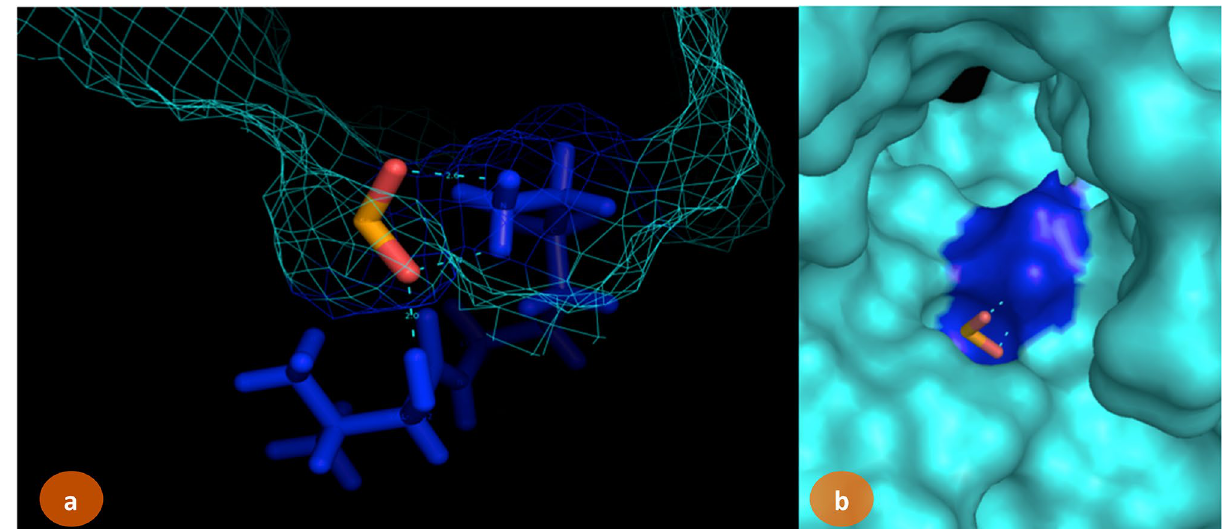
Figure 8. SeO2 interaction map with BRCA2 protein. LYS163 and VAL162 residues involved to interact with SeNPs. Blue colored regions are interacted surface. ( a ) Wired representation of cavity involved to form between NP and residues. ( b ) Surface representation of active site cavity for SeNPs interactions.